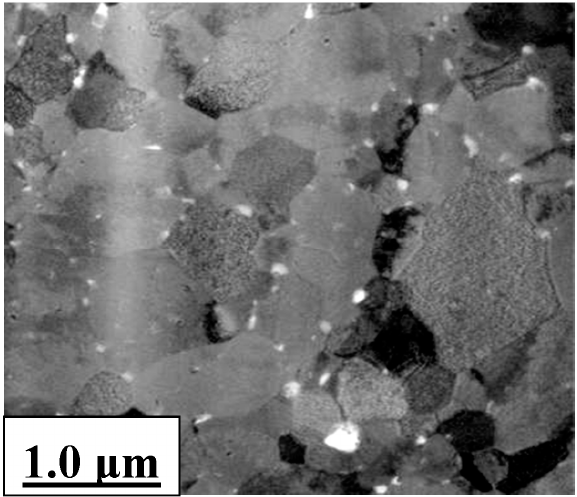
Figure 3. Cross-sectional SEM images of γ -Al 2 O 3 -doped Bi 0.4 Sb 1.6 Te 3 disks after vacuum hot pressing at 573 K under a pressure of 0.7 GPa for 30 min (black particles: γ -Al 2 O 3 ).